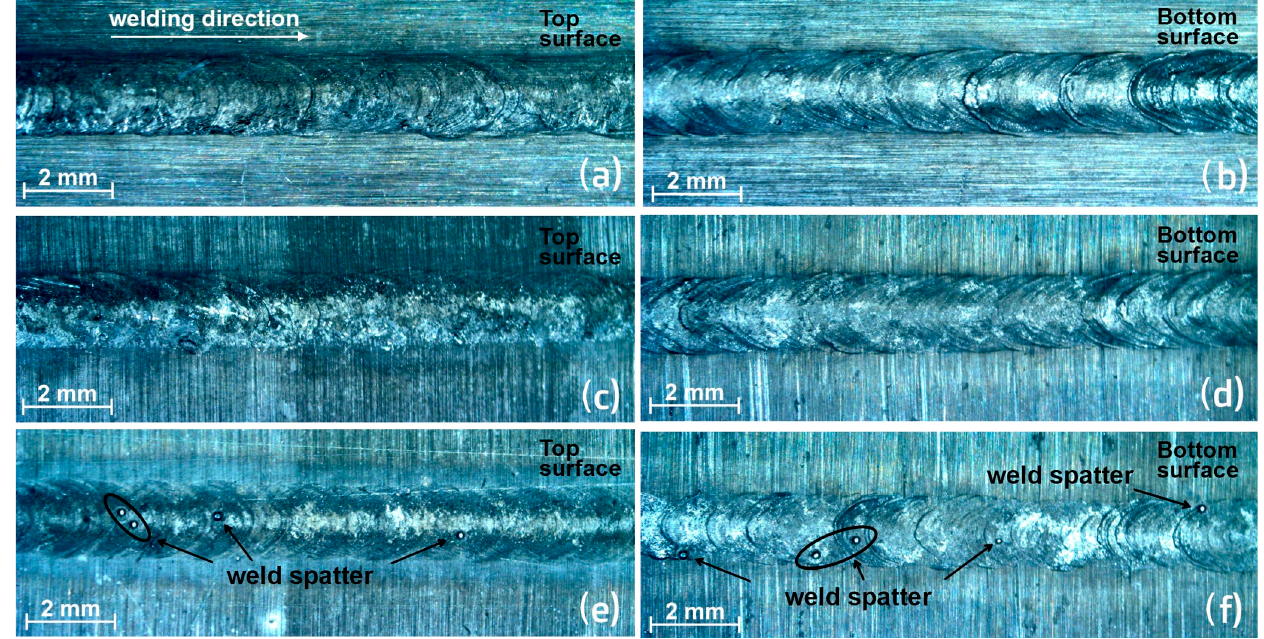
Figure 2. Weld beads and weld roots of laser weld joints: ( a , b ) 130 cm/min, ( c , d ) 70 cm/min, ( e , f ) 0 cm/min.